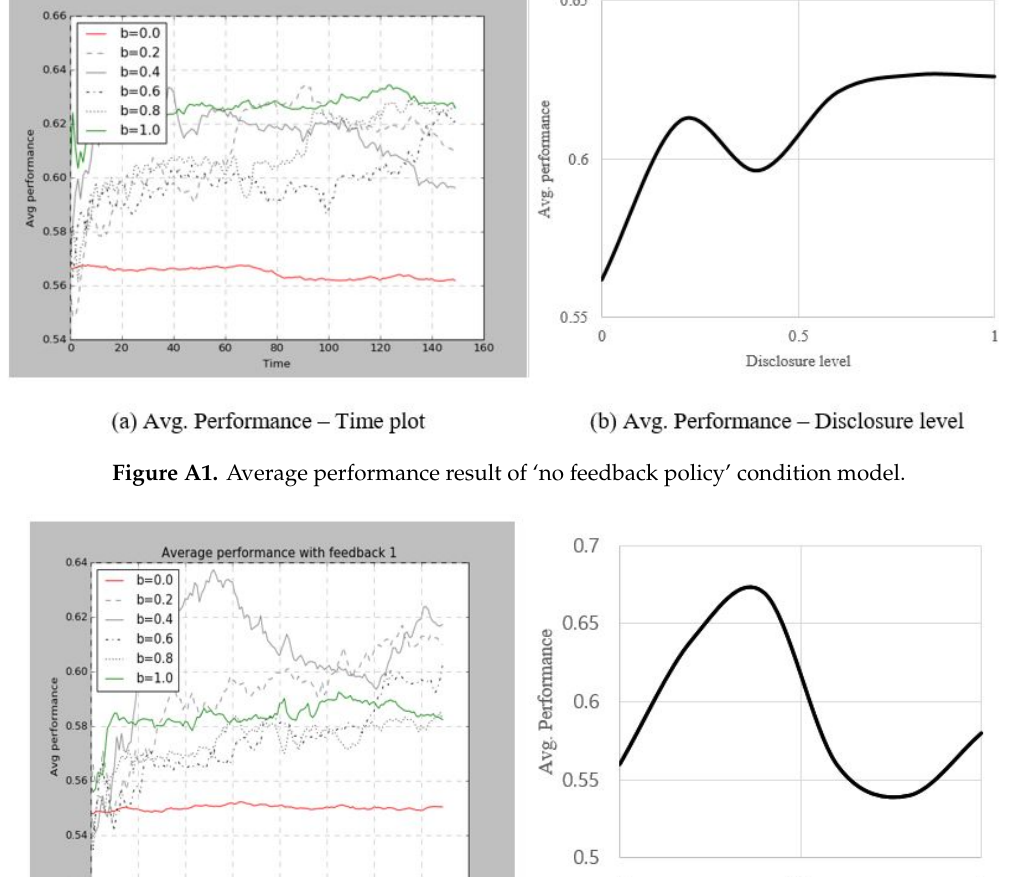
Figure A3. Average performance result of ‘positive feedback to low-performed group’ condition model.